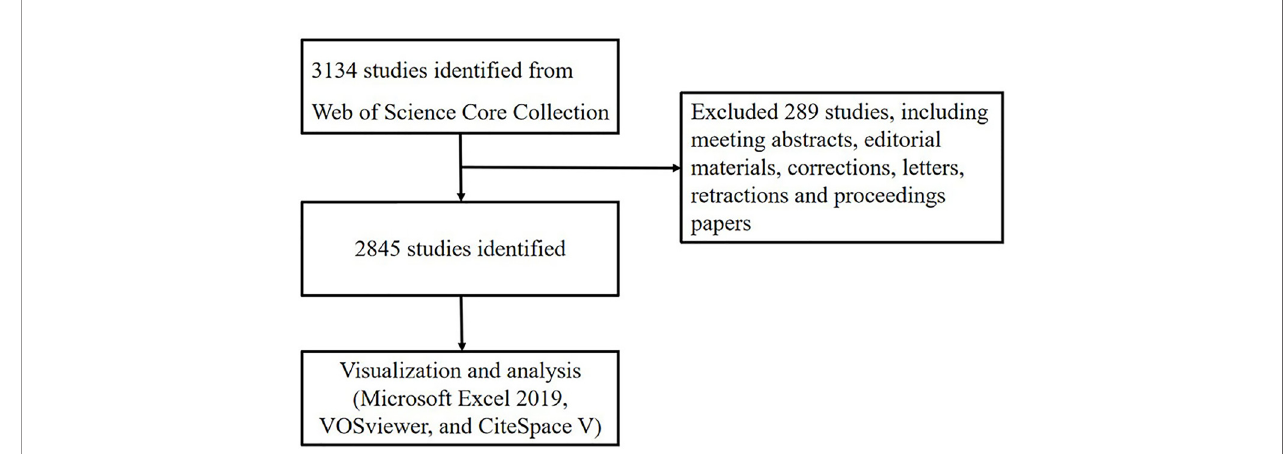
FIGURE 1 | Flowchart of literature